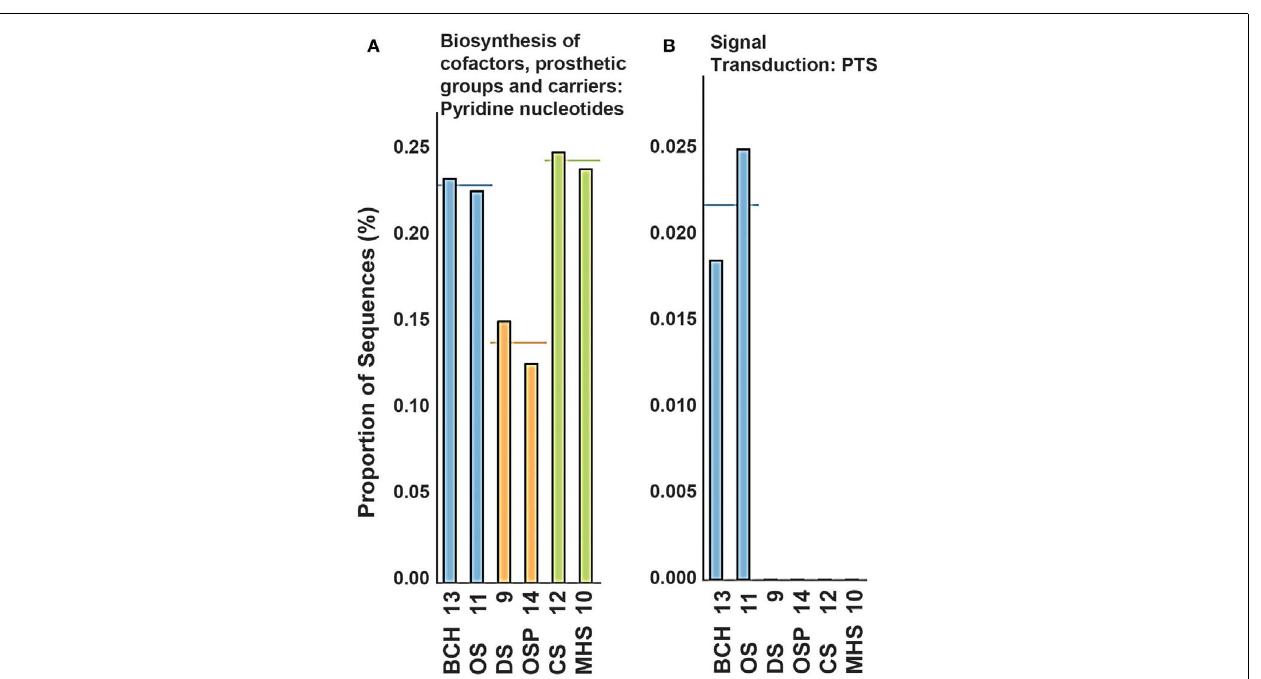
respectively] .The relative proportion of sequences identified within each site are indicated (sites colored as before), and site pairs with similar geochemistry and Aquificales populations reveal replicate behavior in these specificTIGRFAMs.